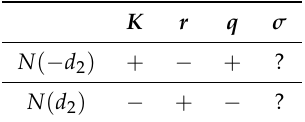
Table 1. Sensitivities of N ( − d 2 ) / N ( d 2 ) , the risk-neutral initial probability that the call/put option ends out of the money at t , to the parameters of the model. + (resp. − ) indicates a positive (resp. negative) sensitivity of the probability to the parameter under investigation. ? indicates that the sign of sensitivity of the probability to the parameter is not unique and might change. S 0 is always kept constant.